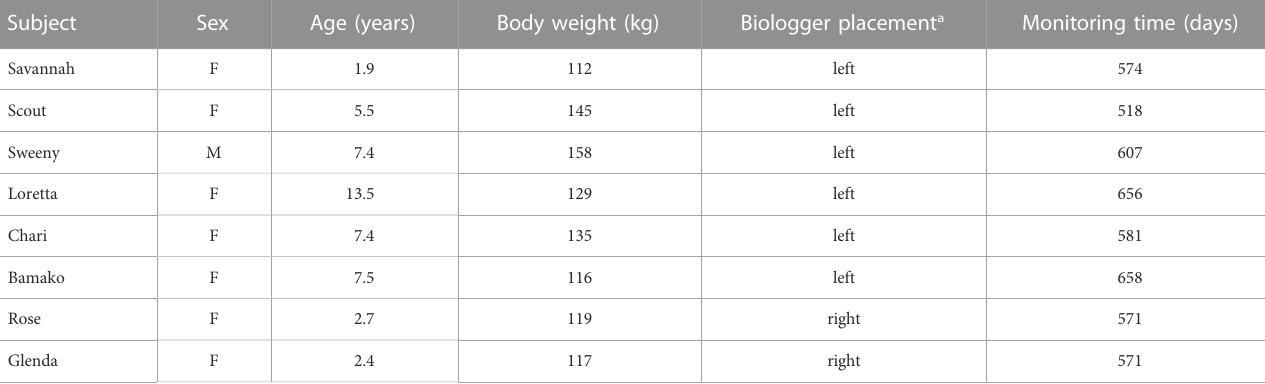
TABLE 1 Demographic information for scimitar-horned oryx implanted with a biologger (Reveal LINQ ™ , Medtronic, MN, United States) for heart rate monitoring at the Smithsonian Conservation Biology Institute, Front Royal, VA, United